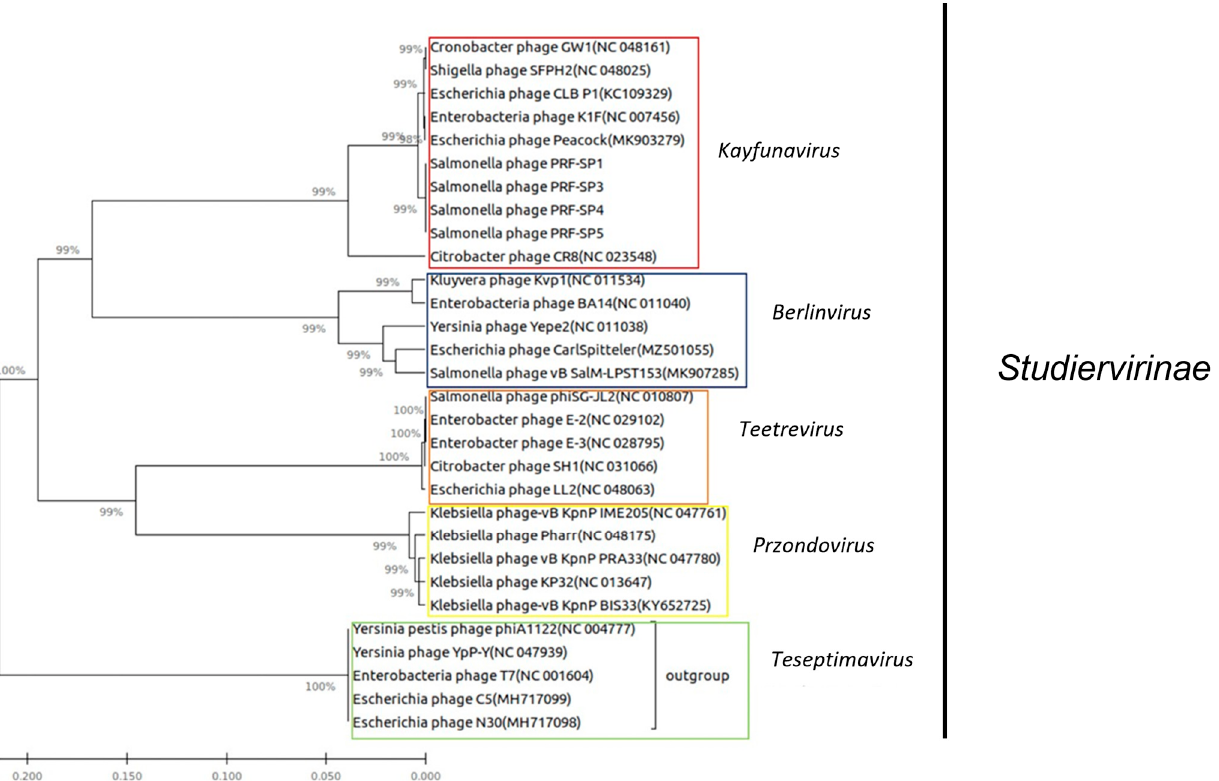
Figure 6. Maximum likelihood (ML) tree of the large terminase subunit of phages from the family Autographviridae and subfamily Studiervirinae . The midpoint rooted tree was inferred based on a ClustalW alignment of terminase large subunit (TerL) amino acid sequences from PRF-SP1, PRF-SP3, PRF-SP4, and PRF-SP5, and other closely related phage genomes available in GenBank. The bootstrap values (expressed as percentages) calculated from 1000 replicates are shown beside each node.